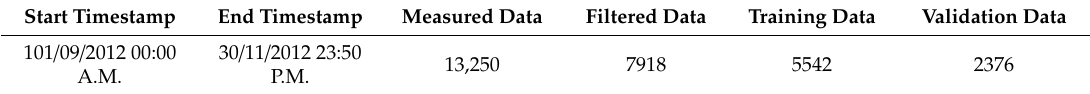
Table 1. Supervisory control and data acquisition (SCADA) data